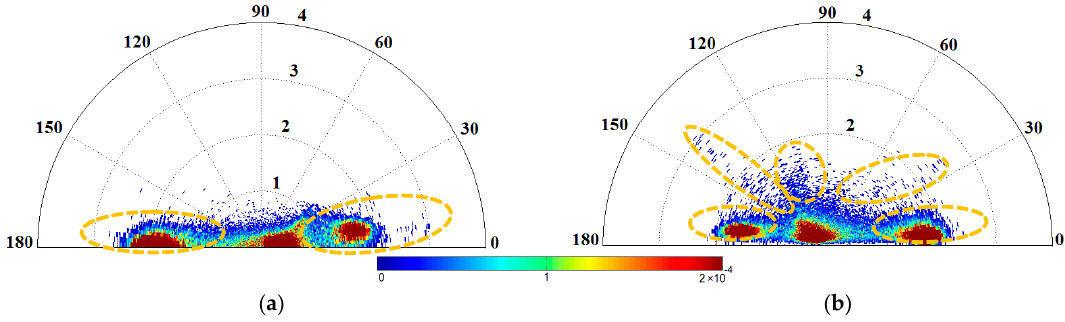
Figure 8. S 2 CVA 2D change representations obtained on X S when: ( a ) M = 2 (two changes are identified); ( b ) M = 5 (five changes are identified). Table 4. Estimated number of changes in multiple CD with different number of selected bands (Yancheng dataset).